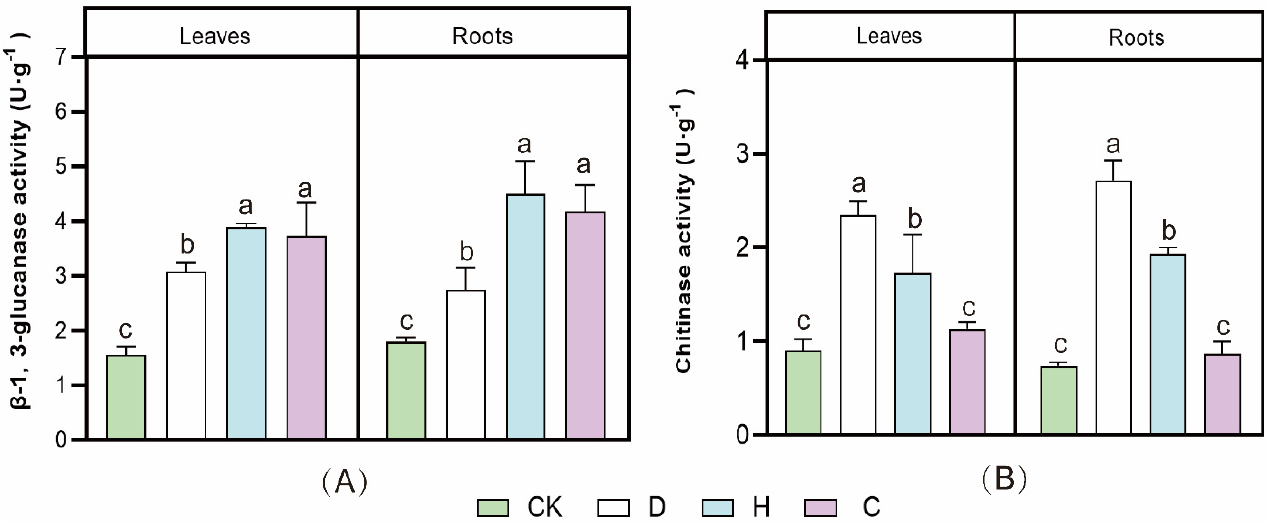
Figure 3. Effect of different concentrations of antifungal peptide P852 on Faba bean roots and leaves ( A ) β -1,3-glucanase and ( B ) chitinase activities. Values are means ± SDs ( n = 3). Bars marked with different letters (a, b, c) represent significant differences ( p < 0.05). The Fusarium wilt of Faba bean was inoculated with H (10 μ g/mL), D (1 μ g/mL), and 10 g/L carbendazim solution (C), and seedlings treated with sterile water served as controls (CK).